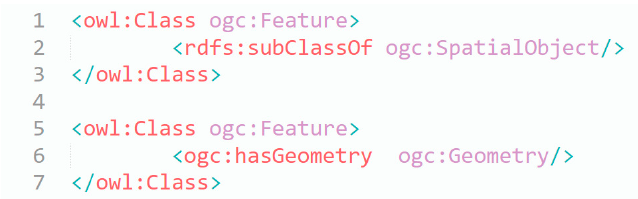
Figure 6. Hierarchical relationship and object attribute relationship.